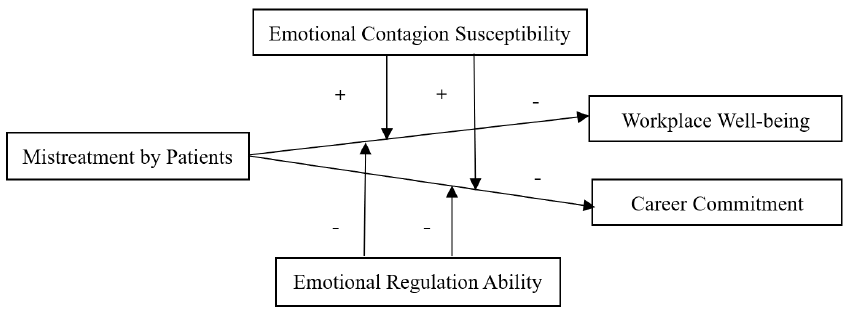
Figure 1. Theoretical Model.